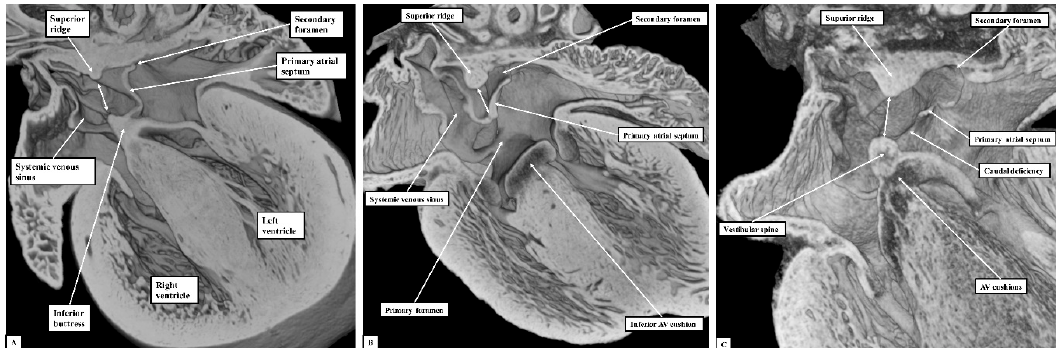
Figure 6. The images show sections prepared in the four-chamber plane from mouse embryos sacrificed at the sixteenth day of development (E15.5). (Panel A ) shows the normal arrangement, with the primary atrial septum forming the floor of the oval fossa (double-headed white arrow). (Panel B ) shows an “ostium primum” defect, with common atrioventricular junction due to failure of formation of the vestibular spine. (Panel C ) shows a large defect in the primary septum adjacent to the vestibular spine, thus producing a caudal defect within the oval fossa. The double-headed white arrow shows the margins of the oval fossa. AV—Atrioventricular.